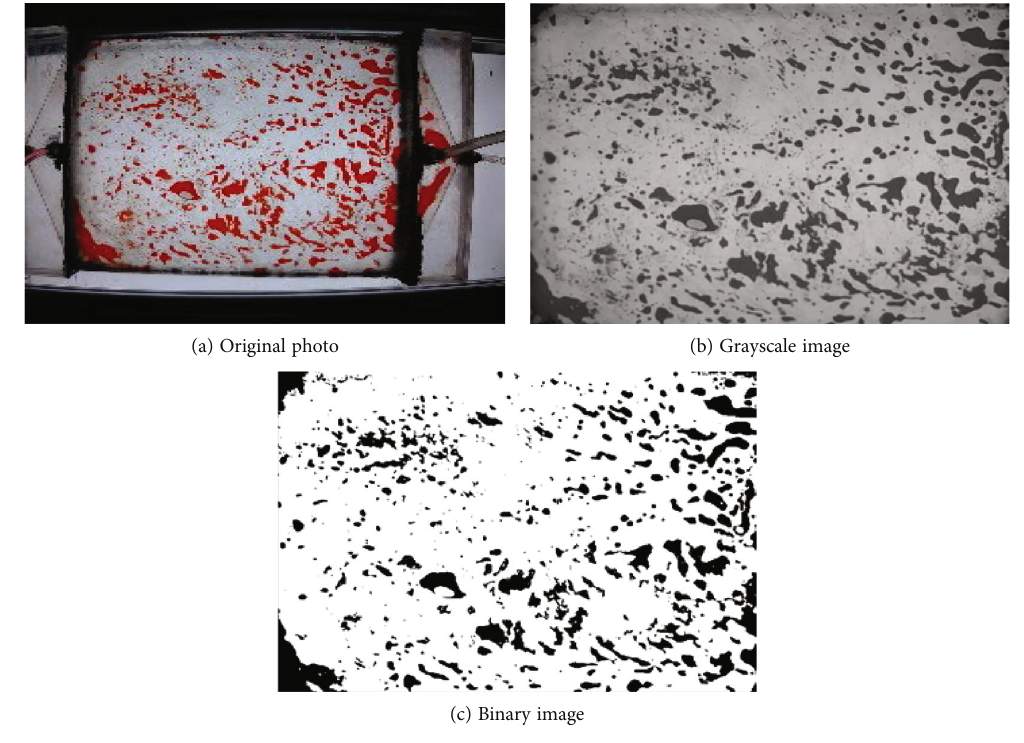
Figure 6: Photo-processing procedure.